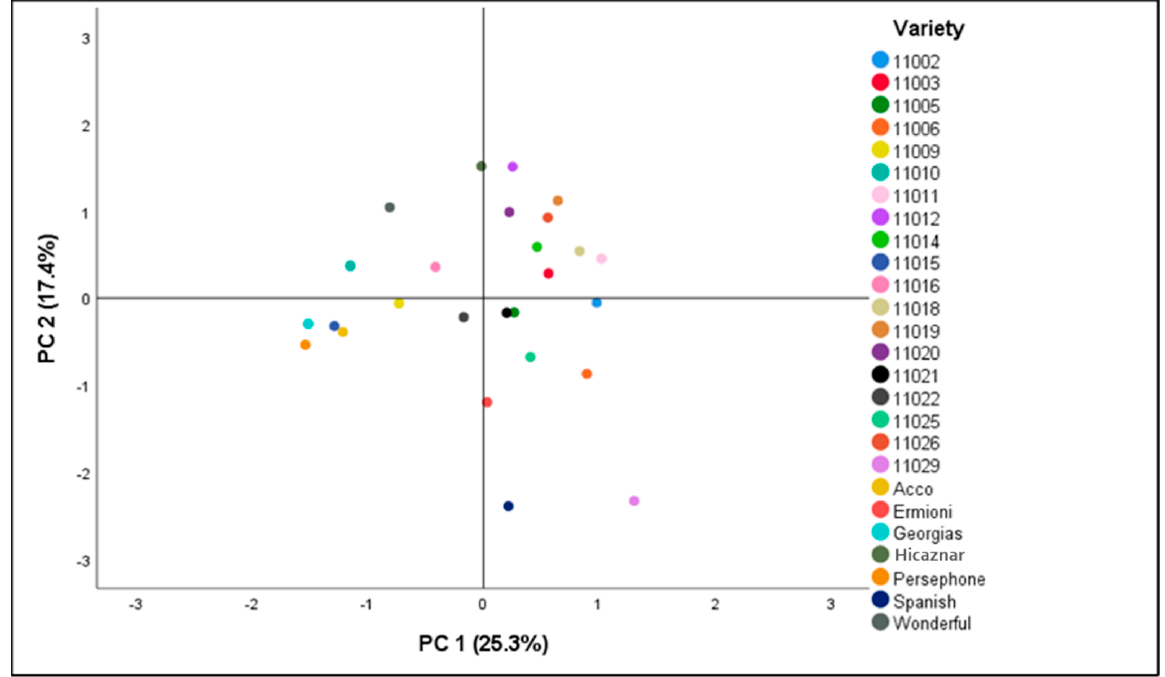
Figure 1. Principal Component Analysis (PCA) loading plot. The points correspond to the Principal Component 1 (PC1) and Principal Component 2 (PC2) score for each variety.